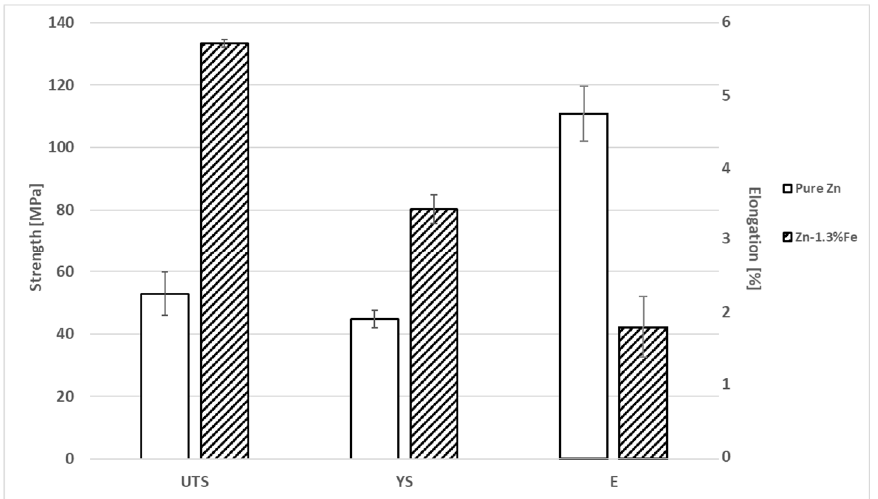
Figure 3. Mechanical properties of pure Zn and Zn–1.3Fe.